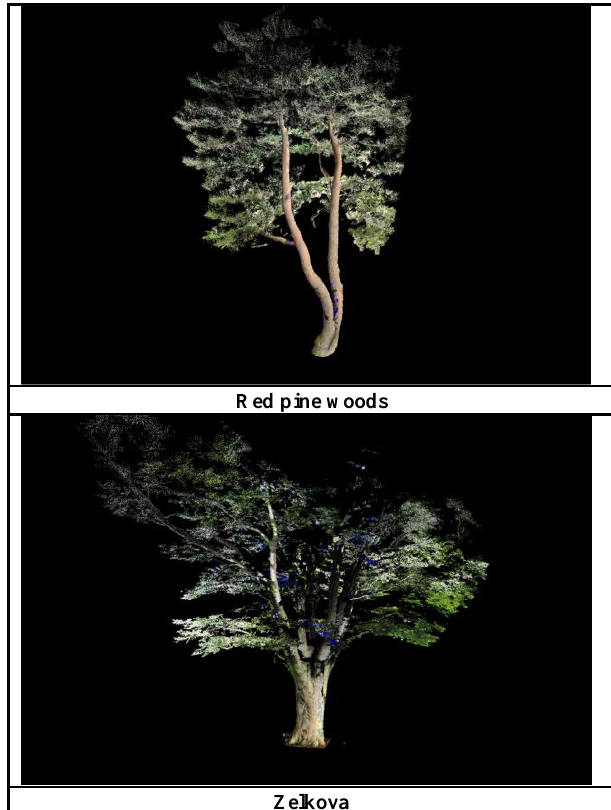
Figure 11. 3D model by using point cloud and triangular mesh